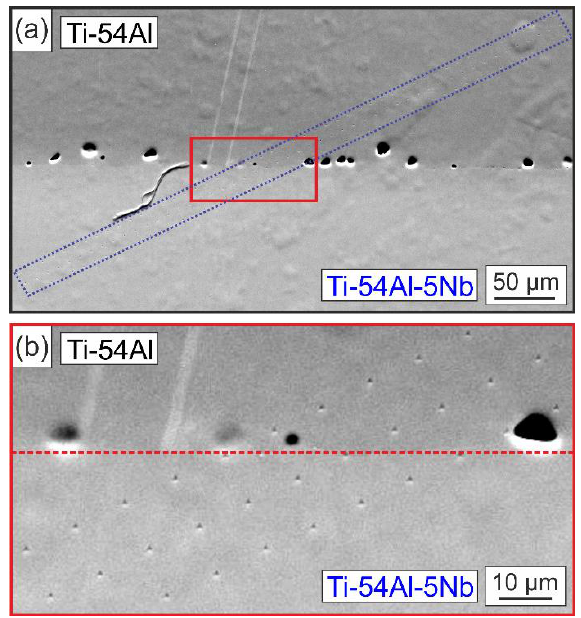
Figure 1. ( a ) Indentation field (blue) across the interface of the Nb-containing diffusion couple between Ti-54Al and Ti-54Al-5Nb aged at 1200 °C for 500 h. The area marked with a red rectangle is shown in ( b ) at a higher magnification with the interface indicated by the dashed line.